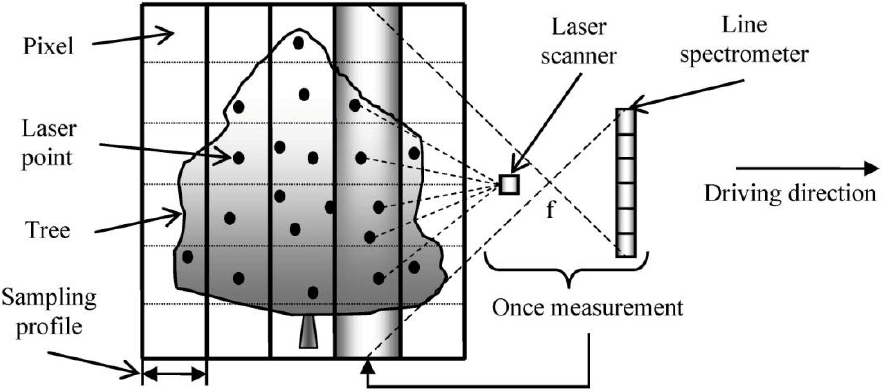
Figure 1. Demonstration of the basic projection geometric models of mobile terrestrial line spectrometer and laser